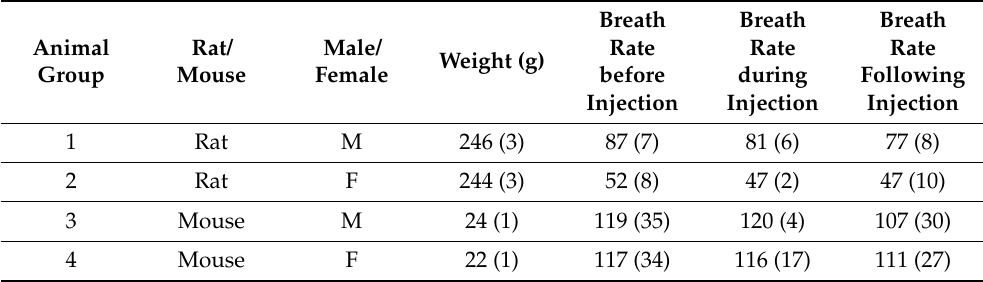
Table 2. Averaged data—animal weight and breath rate before, during, and following a saline injection *, under